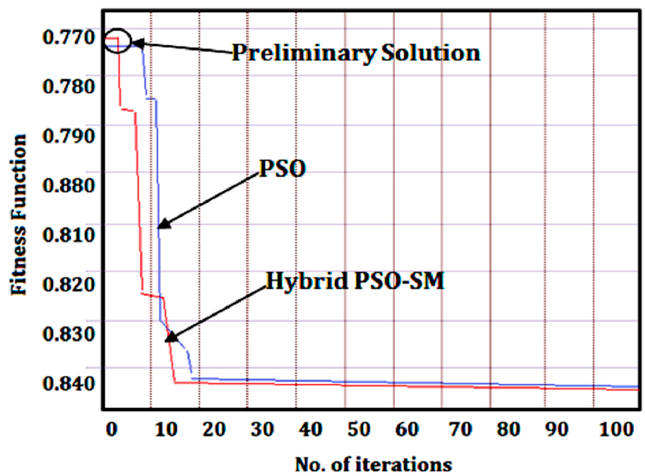
Figure 8. Convergence characteristics graphs for bi-objective optimization of combined objective.